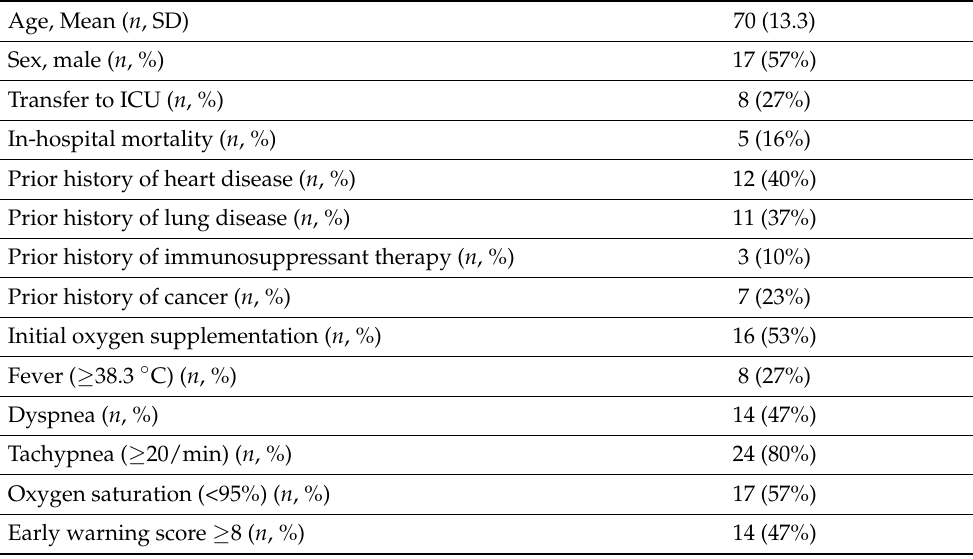
Table 1. Patient demographics and clinical baseline